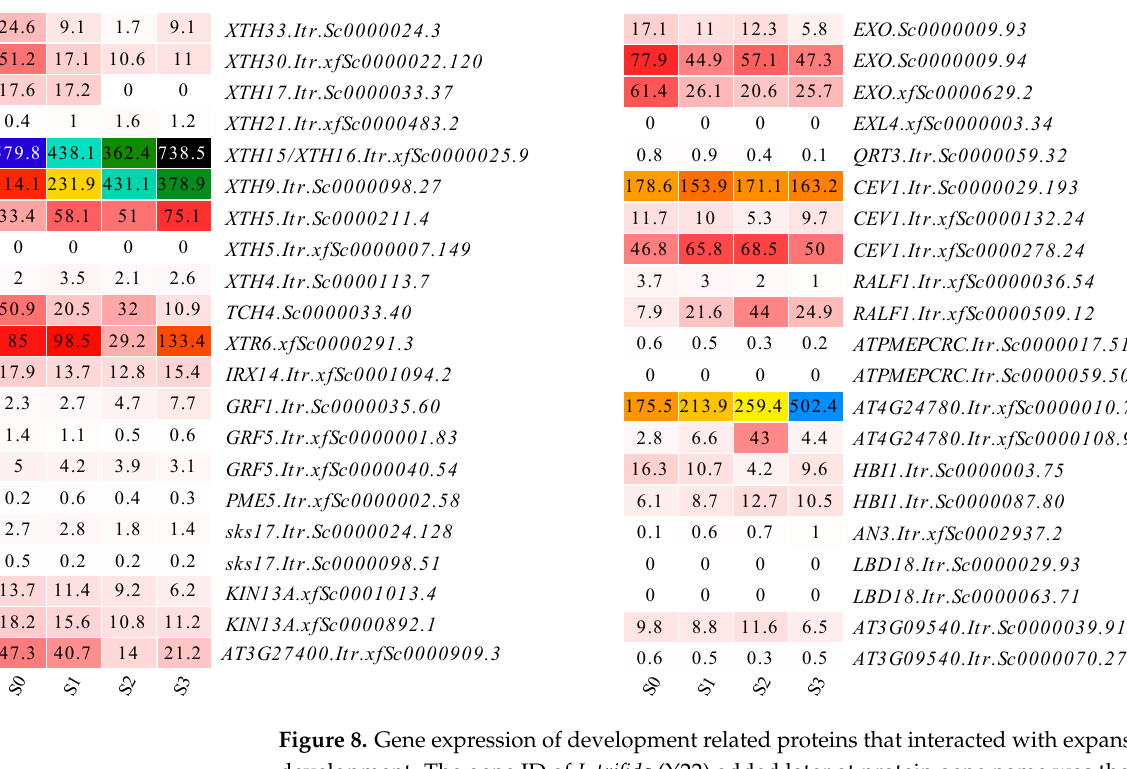
Table S2: The expansin genes of I. nil and I. triloba ; Table S3: The duplication type of expansin